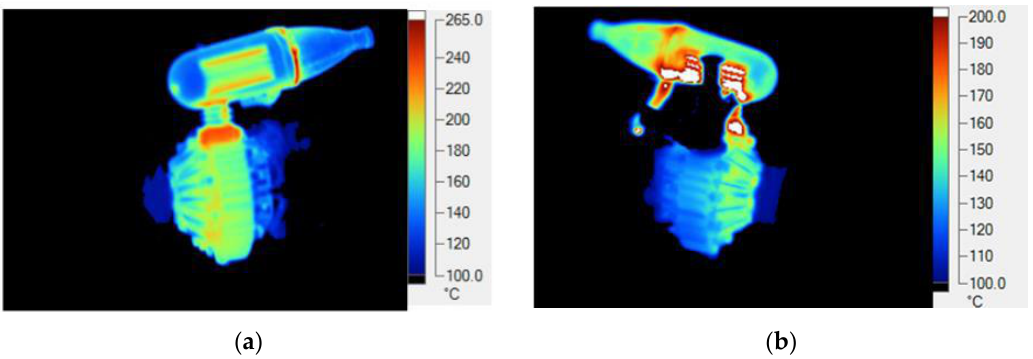
Figure 18. Temperature test chart of micro engine ( a ) without microtextures and ( b ) with microtextures.